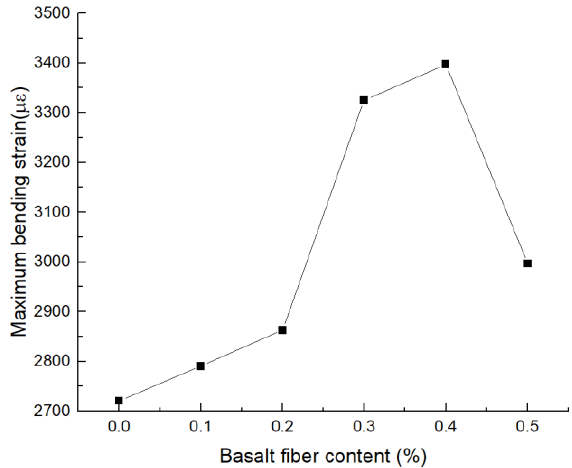
8 of 12 Figure 4. Dynamic stability (DS) of asphalt mixture containing variousdosages of basalt fiber. 3.3. Low-Temperature Property Figure 5 displays the maximum bending strain of the asphalt mixture containing different dosages of basalt fiber. As seen from Figure 5, the development of low-temperature property is similar to that of the high-temperature stability with the increase of basalt fiber dosages.